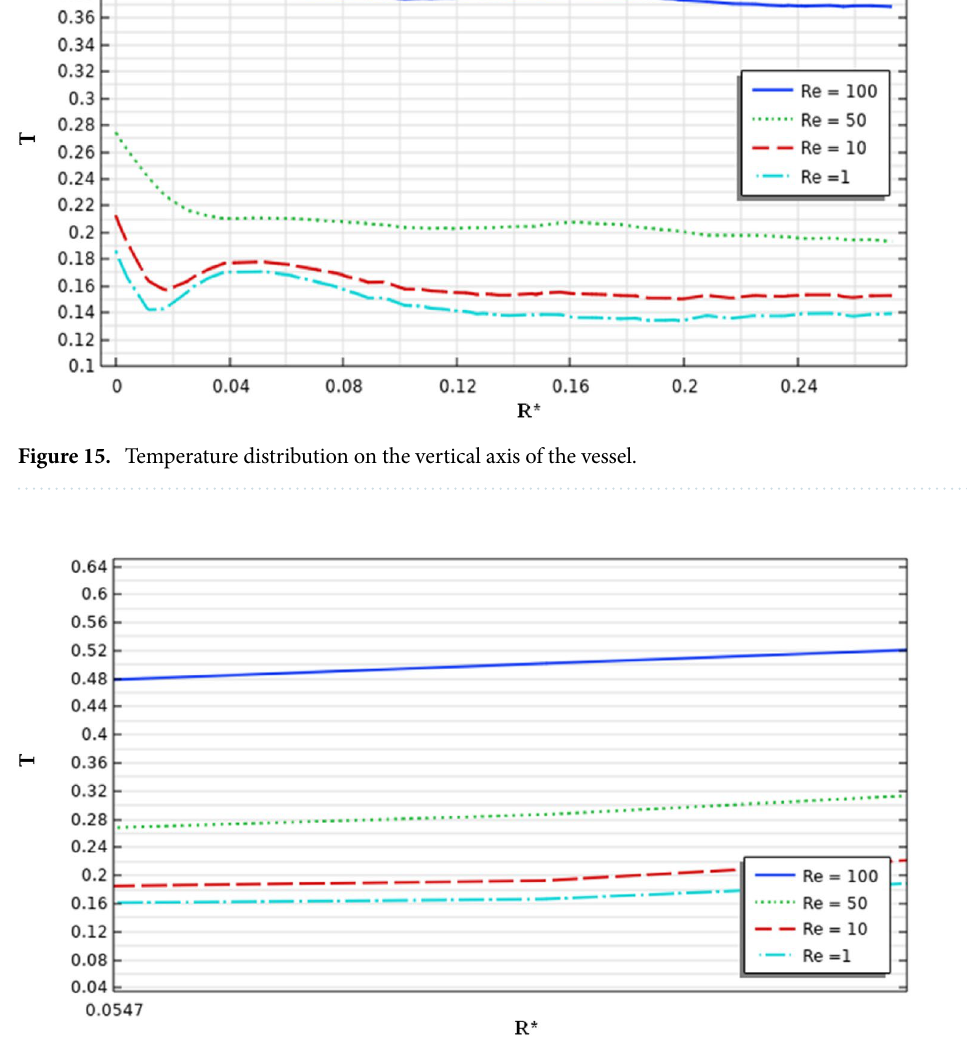
Figure 16. Temperature distribution on the vertical axis of the vessel.